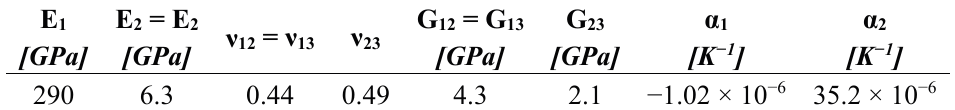
Table 1. Mechanical (compression) and thermal properties of M18/M55J prepreg.